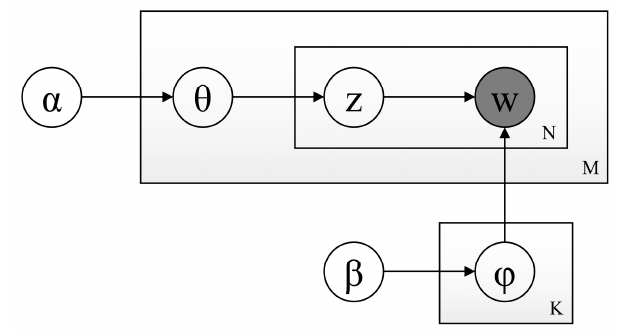
Figure 3. Graphical model representation of LDA.